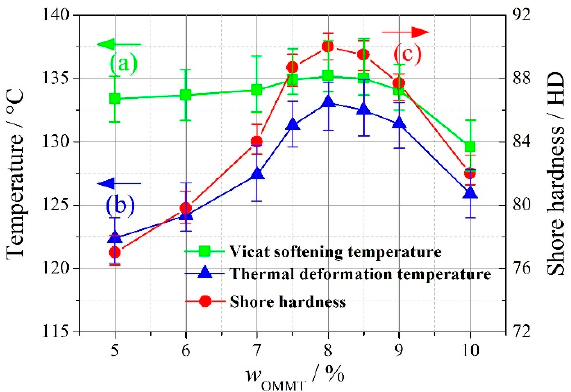
Figure 2. The heat resistance and hardness changes of OMMT-modified UHMWPE with increasing amounts of OMMT. ( a ) Vicat softening temperature, ( b ) thermal deformation temperature, ( c ) Shore hardness (repeated three times).